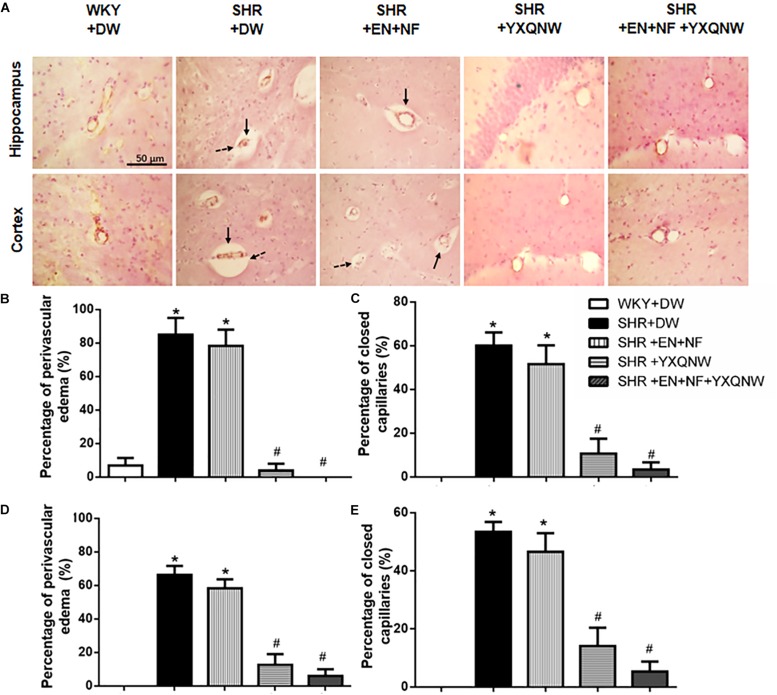
YXQNW inhibits the perivascular edema and reduces the number of closed capillaries in the hippocampus and cortex of SHR. (A) Representative images in the region between CA1 to DG of hippocampus and region of cortex stained by immunohistochemistry staining for CD31 in all the groups. Dotted arrows stand for closed capillaries and solid arrows stand for blood vessels with perivascular edema. Bar = 50 μm. (B) The percentage of the capillaries with perivascular edema to the total number of capillaries in a region between CA1 and DG of hippocampus evaluated in five randomly selected micrographs for each animal. (C) The percentage of the closed capillaries to the total number of capillaries in hippocampus evaluated in five randomly selected micrographs for each animal. (D) The percentage of the capillaries with perivascular edema to the total number of capillaries in cortex evaluated in five randomly selected micrographs for each animal. (E) The percentage of the closed capillaries to the total number of capillaries in cortex evaluated in five randomly selected micrographs for each animal. ∗P < 0.05 vs. control group, #P < 0.05 vs. SHR + DW group. n = 20.